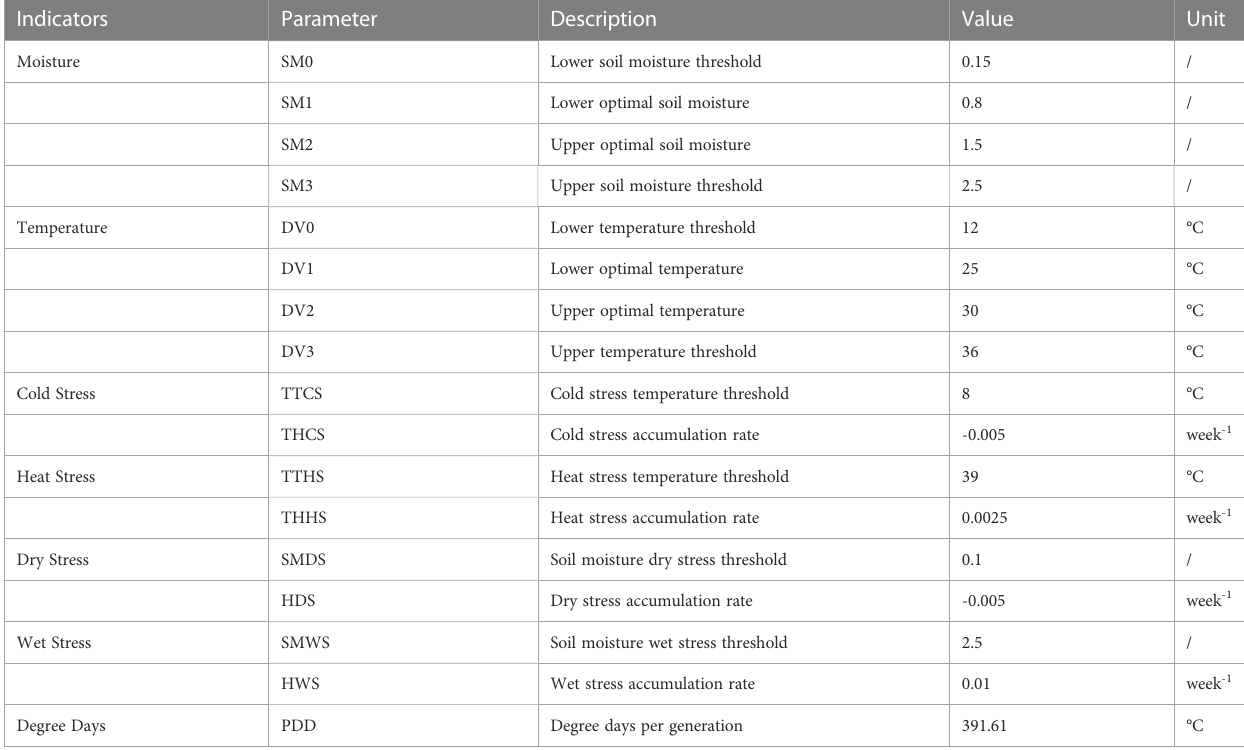
TABLE 1 CLIMEX parameter values used for FAW suitable distribution